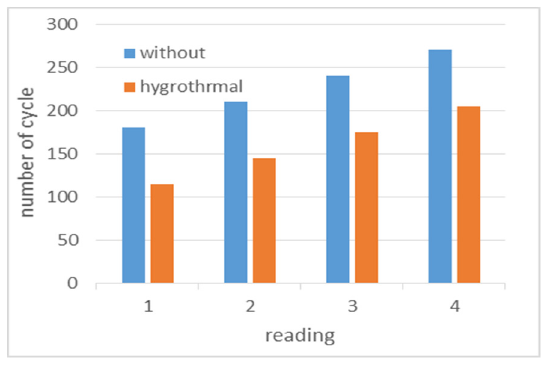
Fig. 5. Humidifier device.